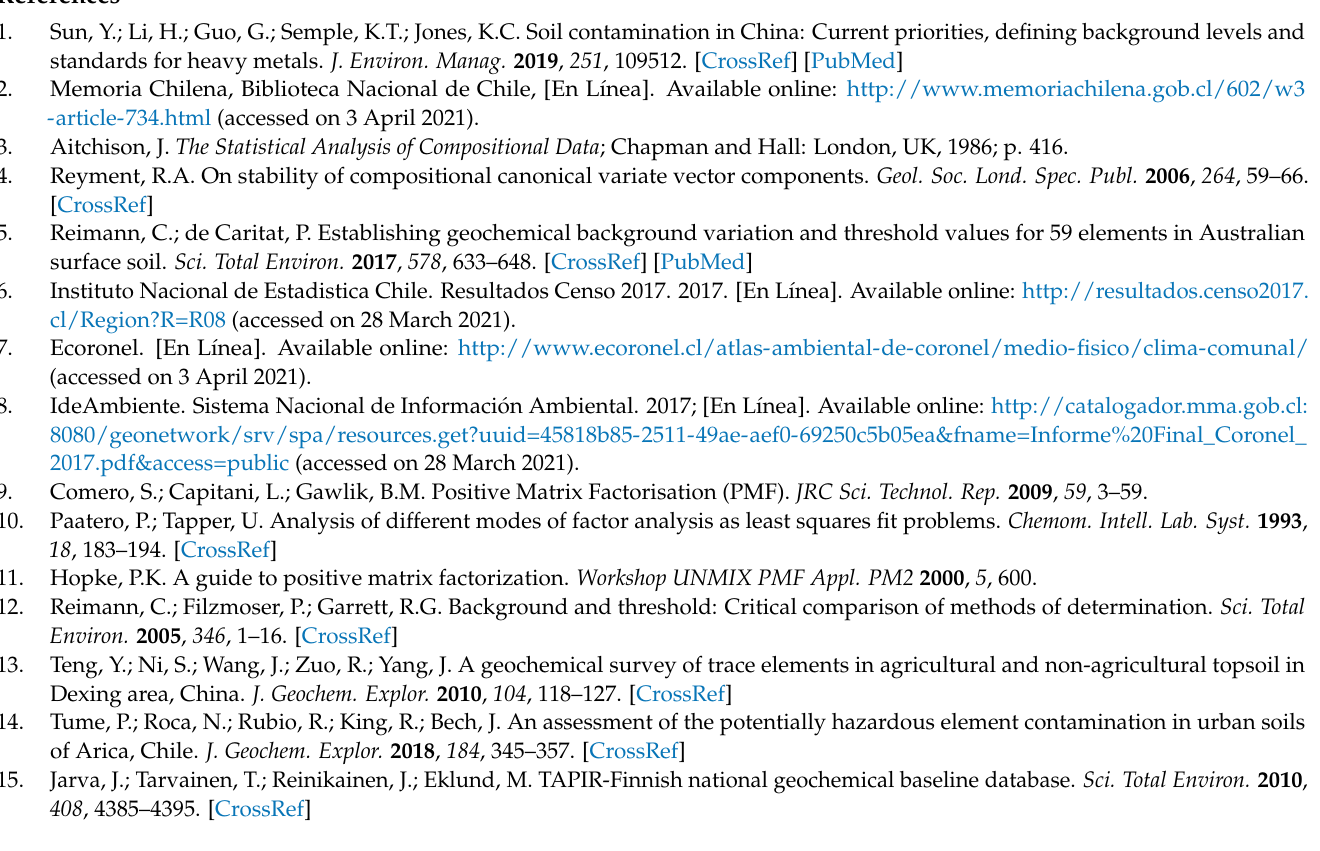
Figure S2: Cumulative variance explained by component, Table S1: Classification of soil contamina- tion according to contamination indexes, Table S2: Values of the factors used in the equations referred to intake, Table S3: Factos used for the calculation of carcinogenic